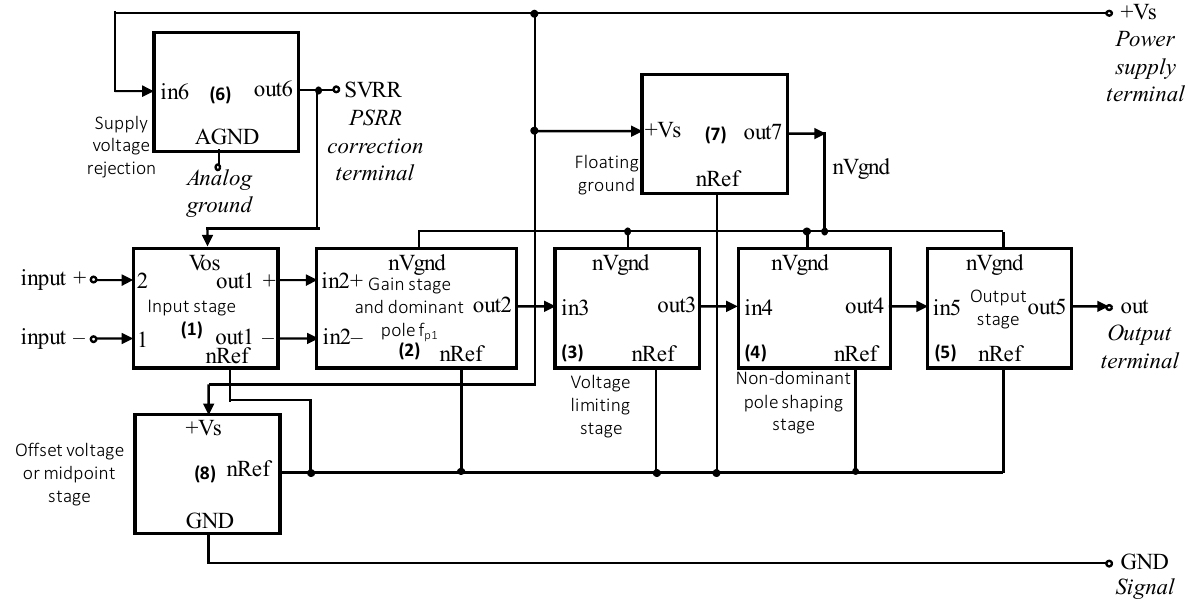
Figure 2. Block diagram of the proposed macromodel for power amplifiers.